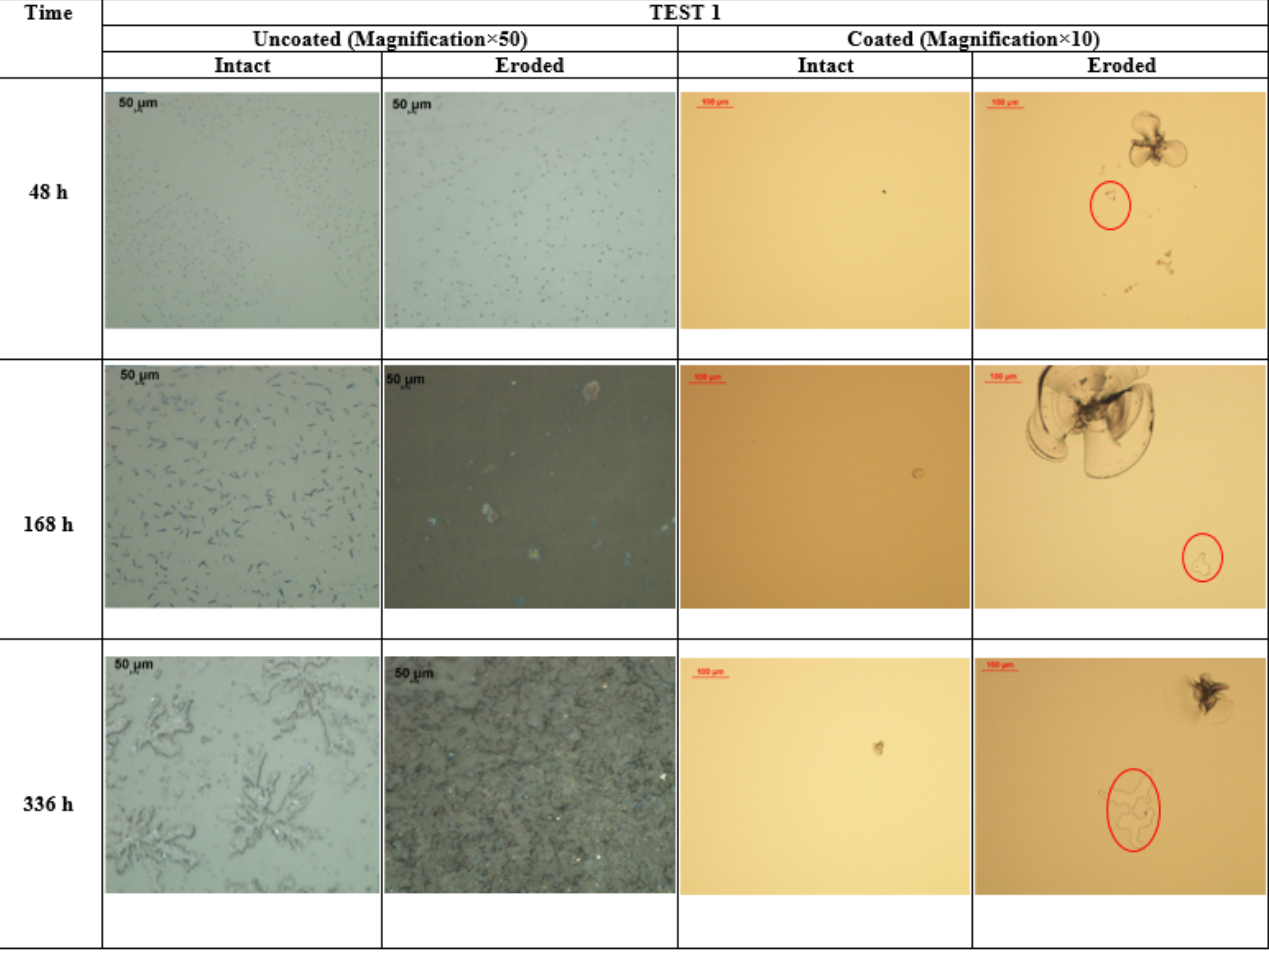
Figure 10. Optical microscope images of tested samples during HAST test N°1 after 48, 168 and 336 h of aging.